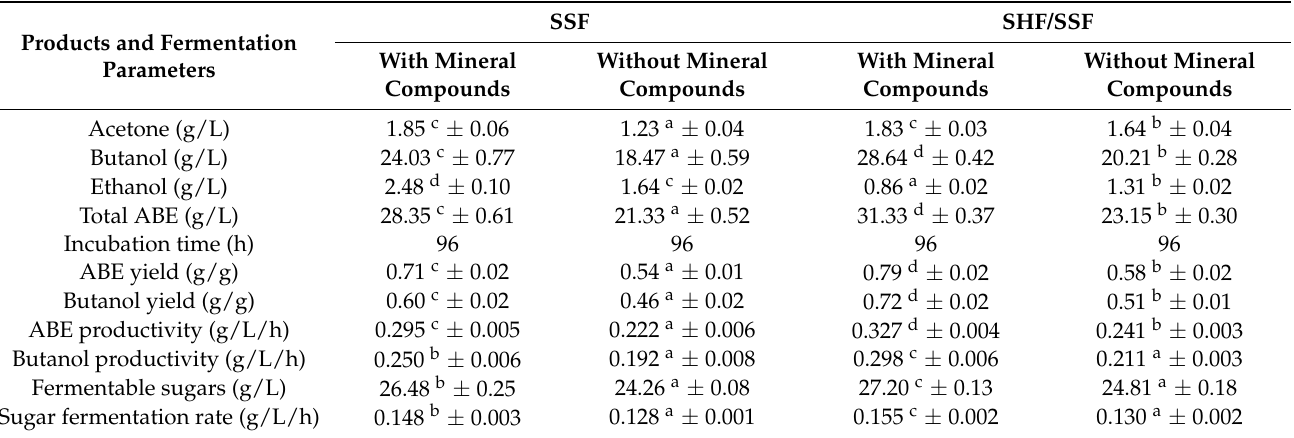
Table 3. Characteristics of acetone–butanol–ethanol fermentation of the corn straw under SSF and SHF-SSF processes with and without mineral